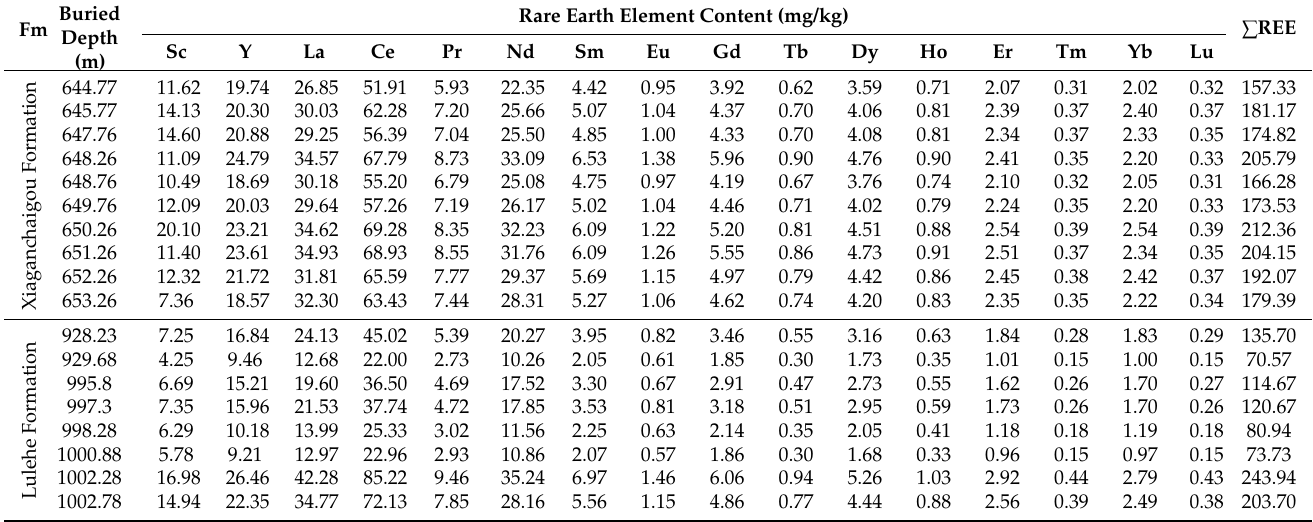
Table 4. REE contents of the Eocene in the Pingtai